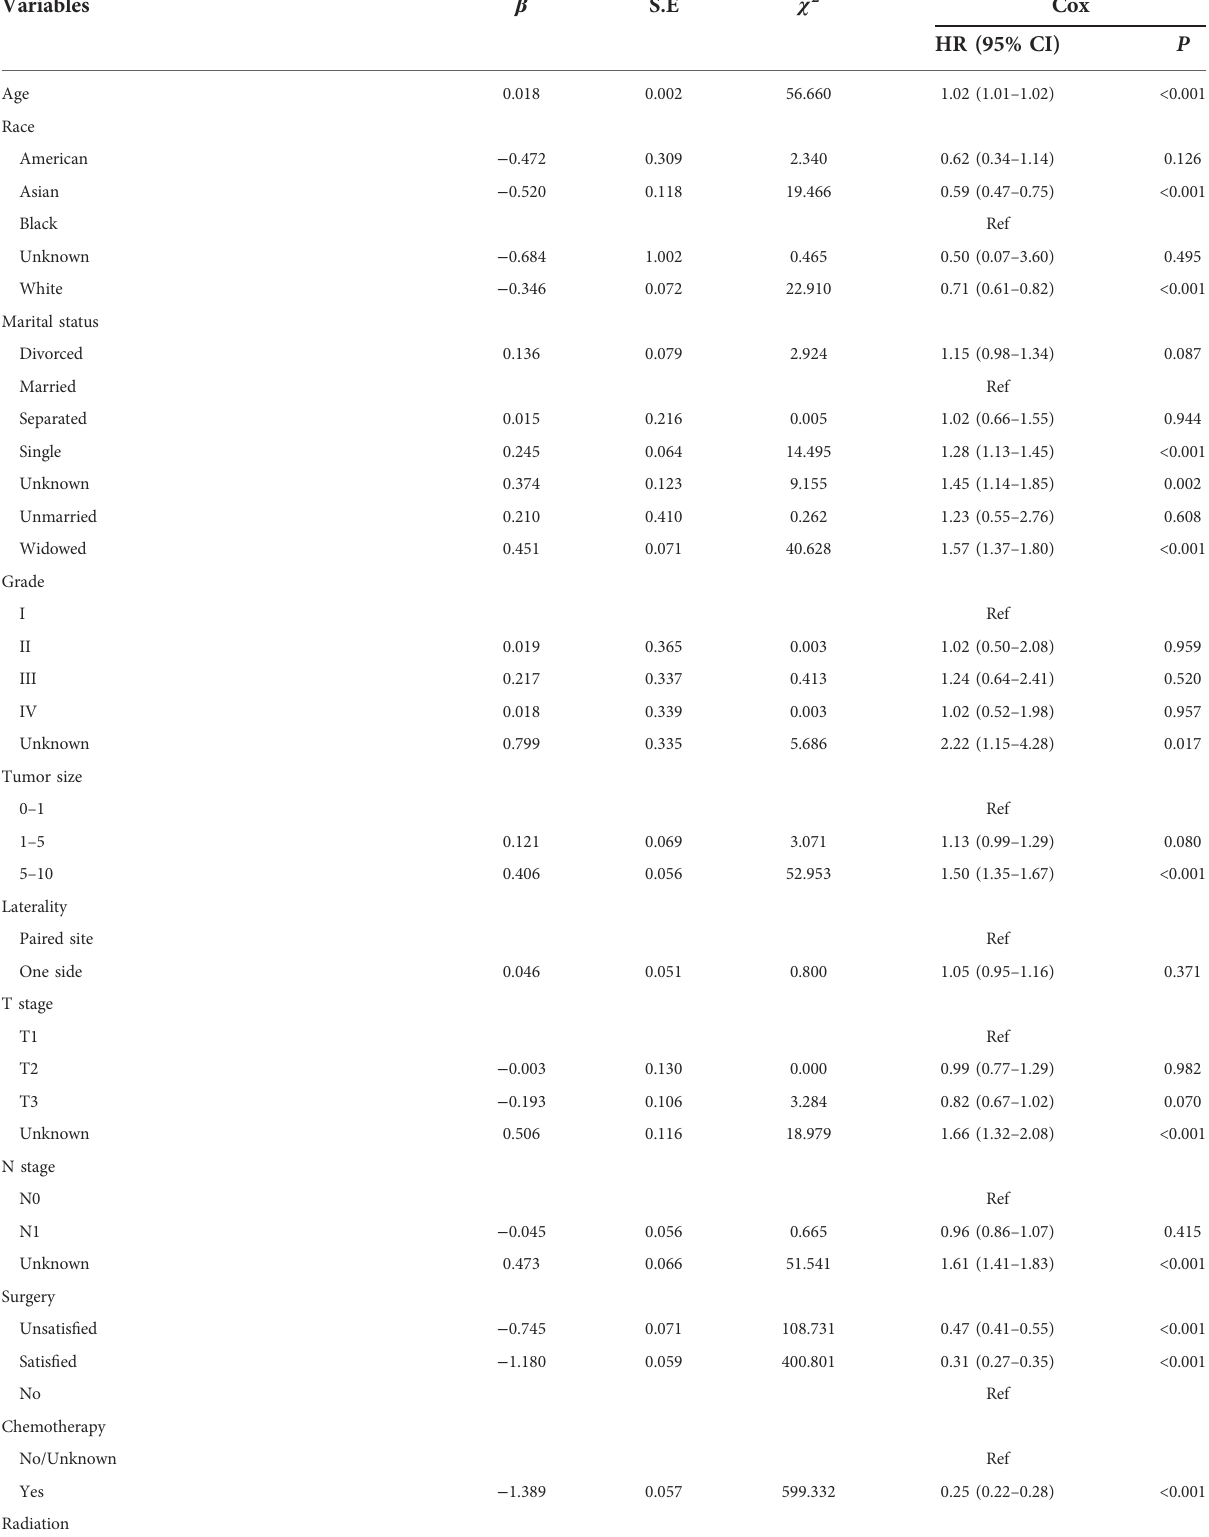
TABLE 3 Univariate analysis for screening the predictors for 2-year overall survival of metastatic ovarian cancer